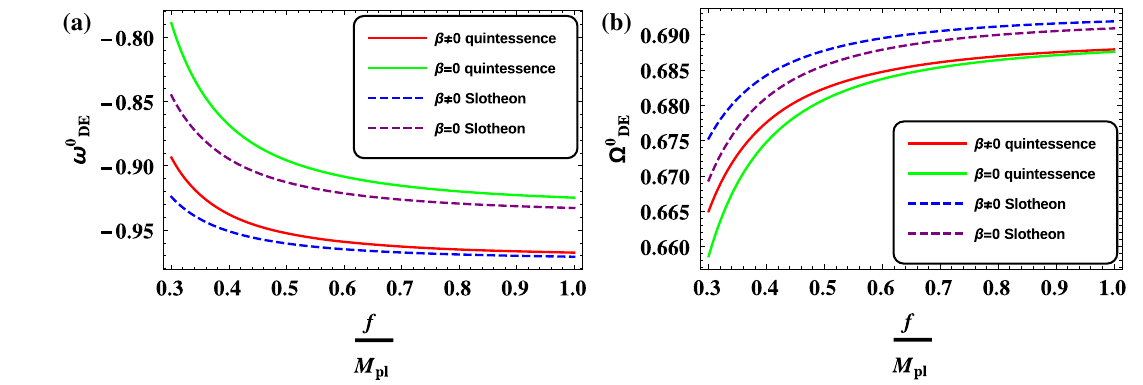
DM–DE interaction are also shown for both the fields. b (Right panel) Same as Fig. 5a but for present value of dark energy density parameter with f DE M pl (cid:12) 0 . See text for detail DE